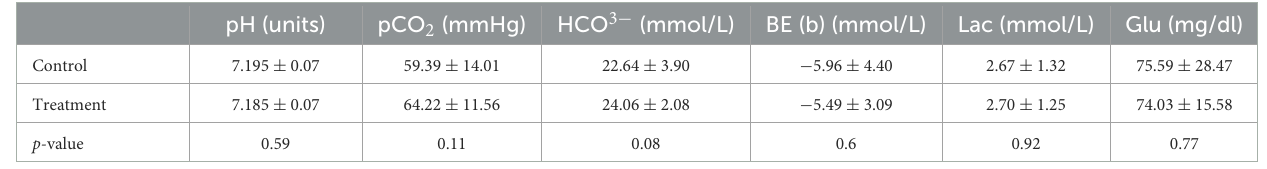
TABLE 2 The umbilical blood gas values of the puppies from dams who received (treatment group) or not (control group) fluid coload.